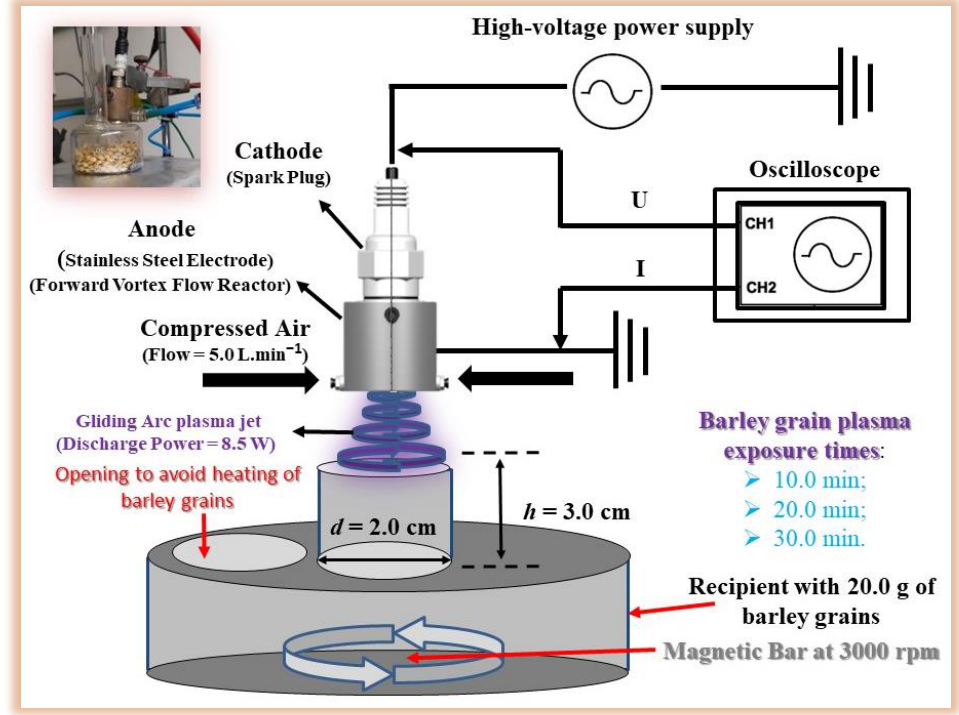
Figure 2. Gliding arc plasma jet experimental setup for treatment of barley grains at 3000 rpm with the aid of a magnetic stirrer device. A photo depicting the setup of the plasma jet used for treatment was added to the